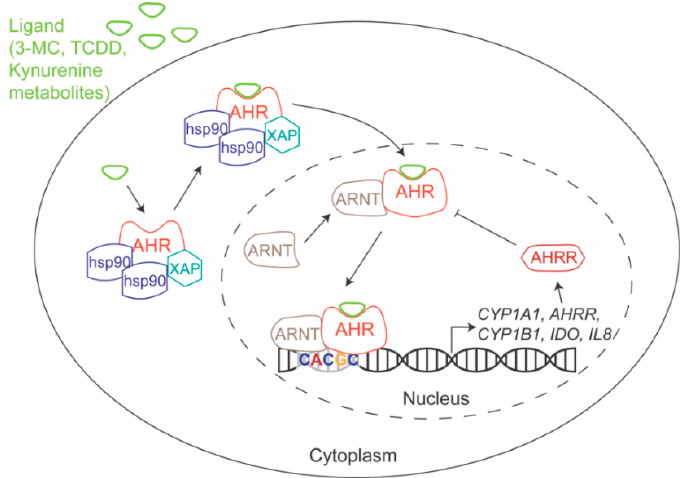
Figure 1. AHR Mechanism of Action. Prior to ligand binding, AHR is bound by cochaperones Hsp90 and XAP, which maintain its localization in the cytoplasm. After ligand binding, it is released from its cochaperones and is transported into the nucleus, where it heterodimerizes with ARNT and binds to DNA — often binding to AHREs (5 ′ -CACGC-3 ′ ) — and regulates gene expression. AHRR is a prototypic AHR target gene and the encoded protein is a negative regulator of AHR. The arrows show the sequence of events that includes interaction, transport, DNA binding, gene expression and RNA translation. The T bar demonstrates that AHRR negatively regulates the AHR-ARNT interaction.